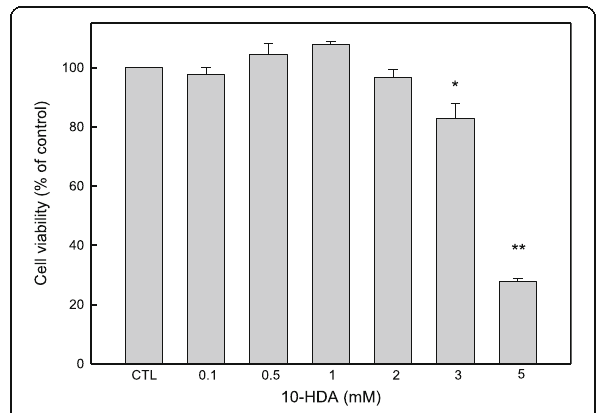
Fig. 1 Percent cell viability of WiDr colon cancer cells after 10-HDA treatment (0.1, 0.5, 1, 2, 3, and 5 mM) for 24 h. CTL represents the control group (without 10-HDA). Each bar is a mean ± SD of the triplicates from one representative experiment. * = p ≤ 0.05; ** = p ≤ 0.01 compared to control